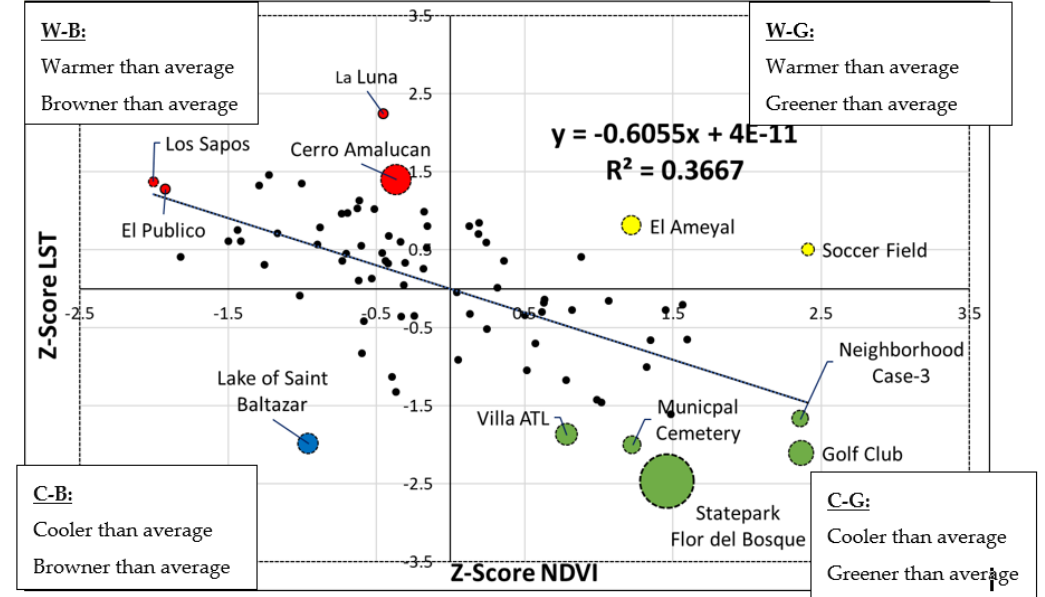
Figure 16. Relationship between NDVI z-score and LST z-score for all 80 urban green spaces (24 May 2011). The colored circles represent the relative size of the UGS, with blue circles representing UGSs with waterbodies greater than 1 km 2 .